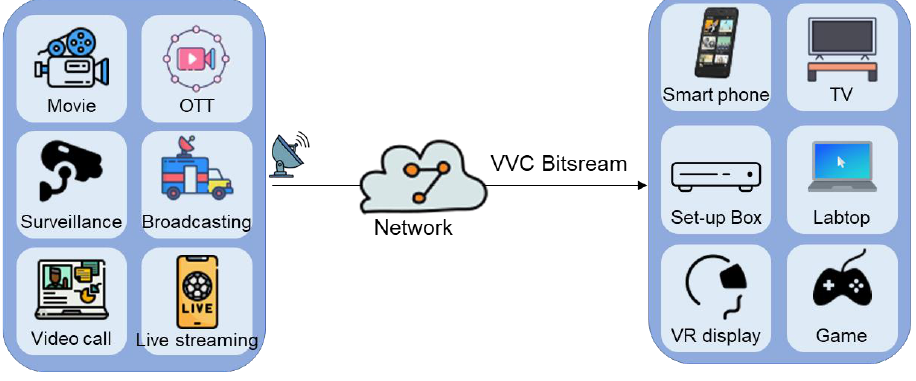
Figure 1. Use case of VVC standard.